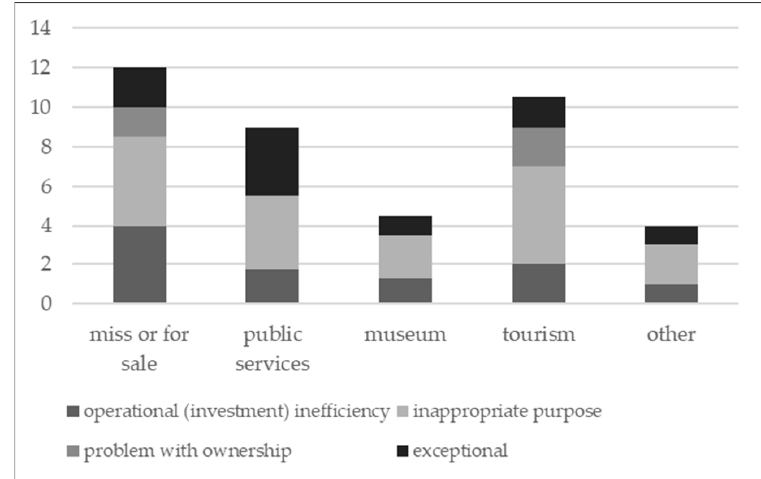
Land 2023 , 12 , 251